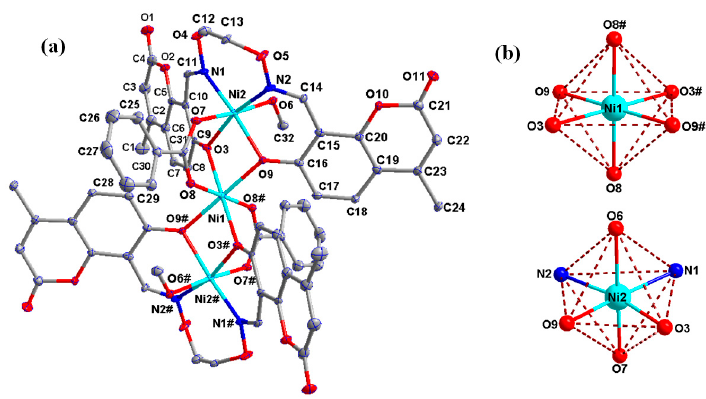
Figure 10. ( a ) X-ray crystal structure and atom numbering of complex 3 with 30% probability displacement ellipsoids; ( b ) Coordination polyhedrons for Ni(II) atoms of complex 3 . Table 8. Selected bond lengths (Å) and angles (°) for complex 3 . Bond Ni1-O3 Bond